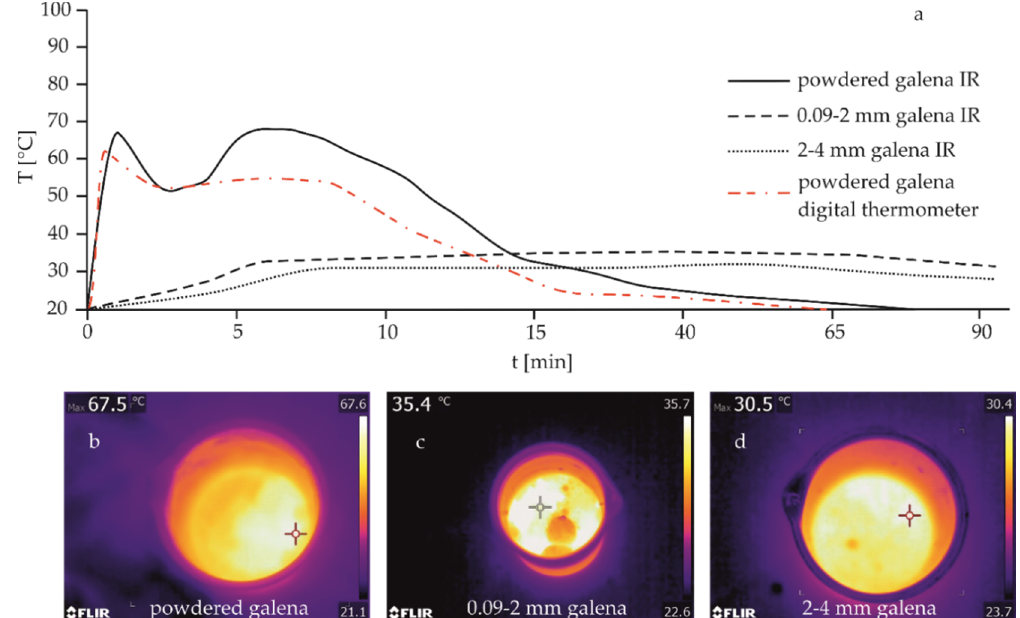
Figure 4. ( a ) Temperature–time graphs for powdered and sieved galena samples as measured using the IR camera and a digital thermometer. ( b – d ) IR thermography images of the temperature maxima ( T max ) for the powdered and sieved galena samples as measured using the IR camera.